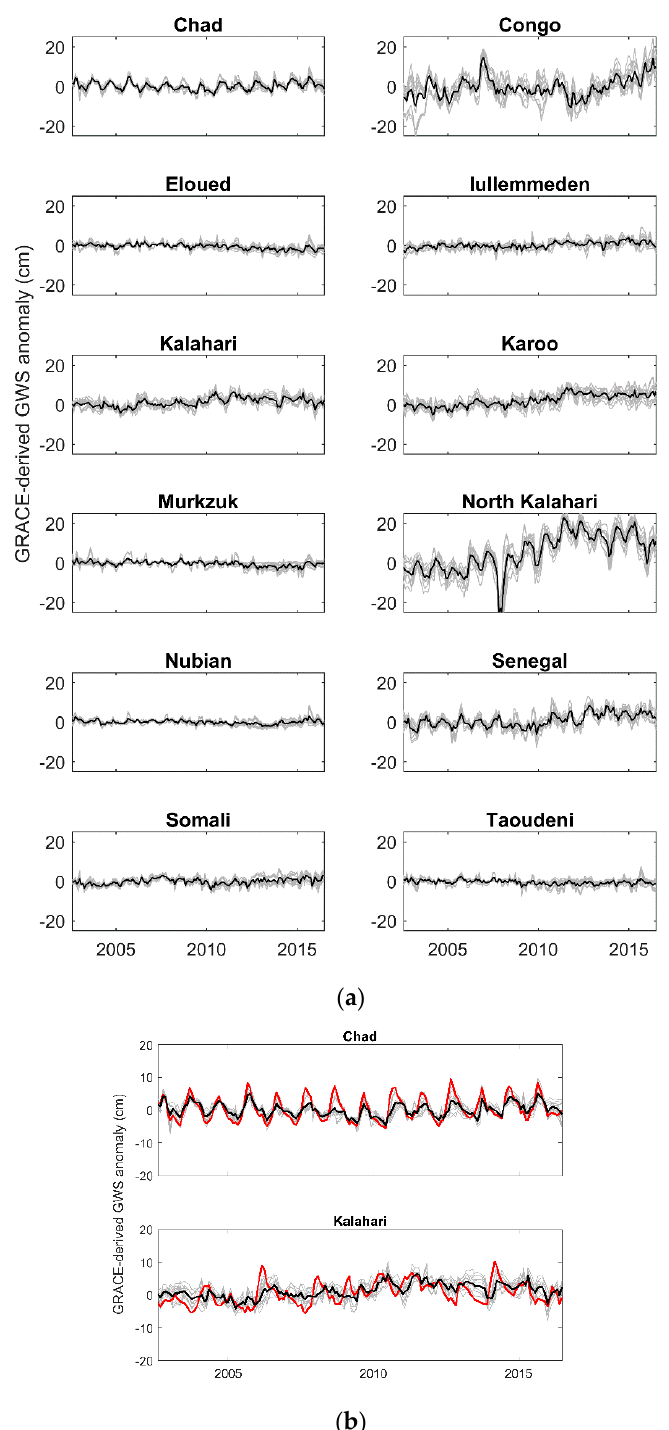
Figure 5. ( a ) Groundwater storage changes ( Δ GWS) estimated from an ensemble of GRACE solutions and LSMs. Solid black line is the ensemble mean, with the grey lines denoting the surrounding range of Δ GWS from the different product combinations. ( b ) Comparison of Δ TWS and estimated Δ GWS between Chad and Kalahari which exemplify the differences in behaviour between the Sahelian (Chad, Iullemmeden) and southern African basins (Karoo, Kalahari). The red line shows the ensemble TWS changes.